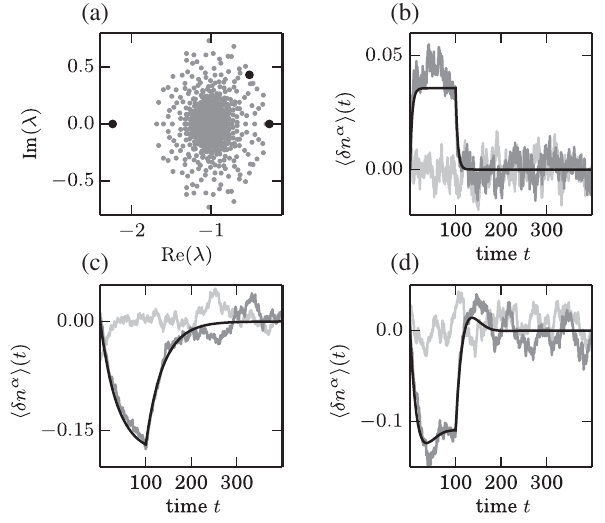
FIG. 6. Linear responses to DC stimuli. Responses (normalized by the number of units N ) to a DC stimulus (duration T ¼ 100 ms) in the direction of one eigenmode (dark gray), the background activity (light gray) measured in simulation, and the analytical prediction of the response curve [Eq. (35), black] obtained from linear response theory. (a) Eigenvalues λ α of the matrix W − 1 . The eigenvalues associated with the modes that are stimulated are depicted by black dots. (b) Stimulation in the direction of the fastest decaying eigenmode λ ¼ − 2 . 24 , with a stimulus size a ¼ 50 . (c) Stimulation in the direction of the slowest decaying eigenmode λ ¼ − 0 . 26 , with a stimulus size a ¼ − 30 . (d) Stimulation in the direction of an eigenmode decaying slowly and oscillatory λ ¼ − 0 . 52 þ 0 . 43 i , with a stimulus size a ¼ − 60 . Responses averaged over 500 repetitions. Other parameters are the same as in Fig.